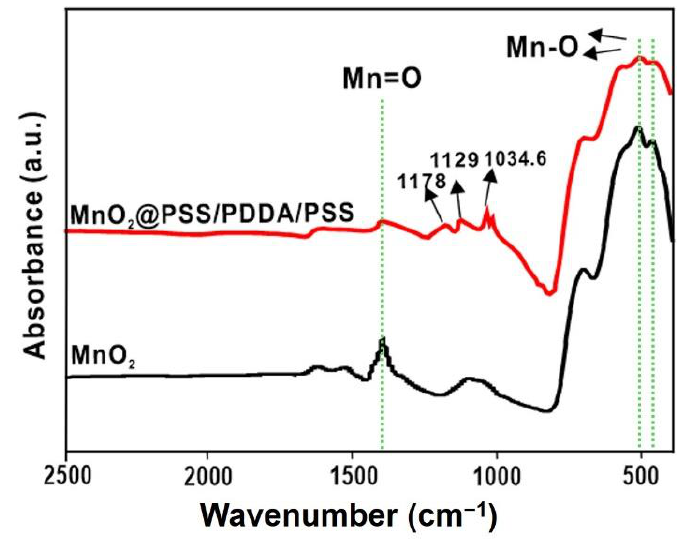
Figure 3. FT-IR spectra of MnO 2 and MnO 2 @PSS/PDDA/PSS.